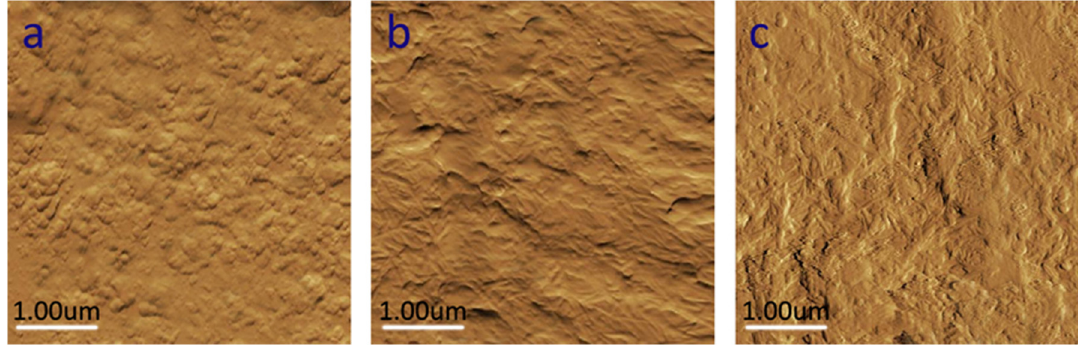
Figure 4. Atomic Force Microscopy (AFM)-micrographs of the surface of coatings: ( a ) WPU, ( b ) WPU/NCC, ( c ) WPU/NCC/AgNPs-5%.